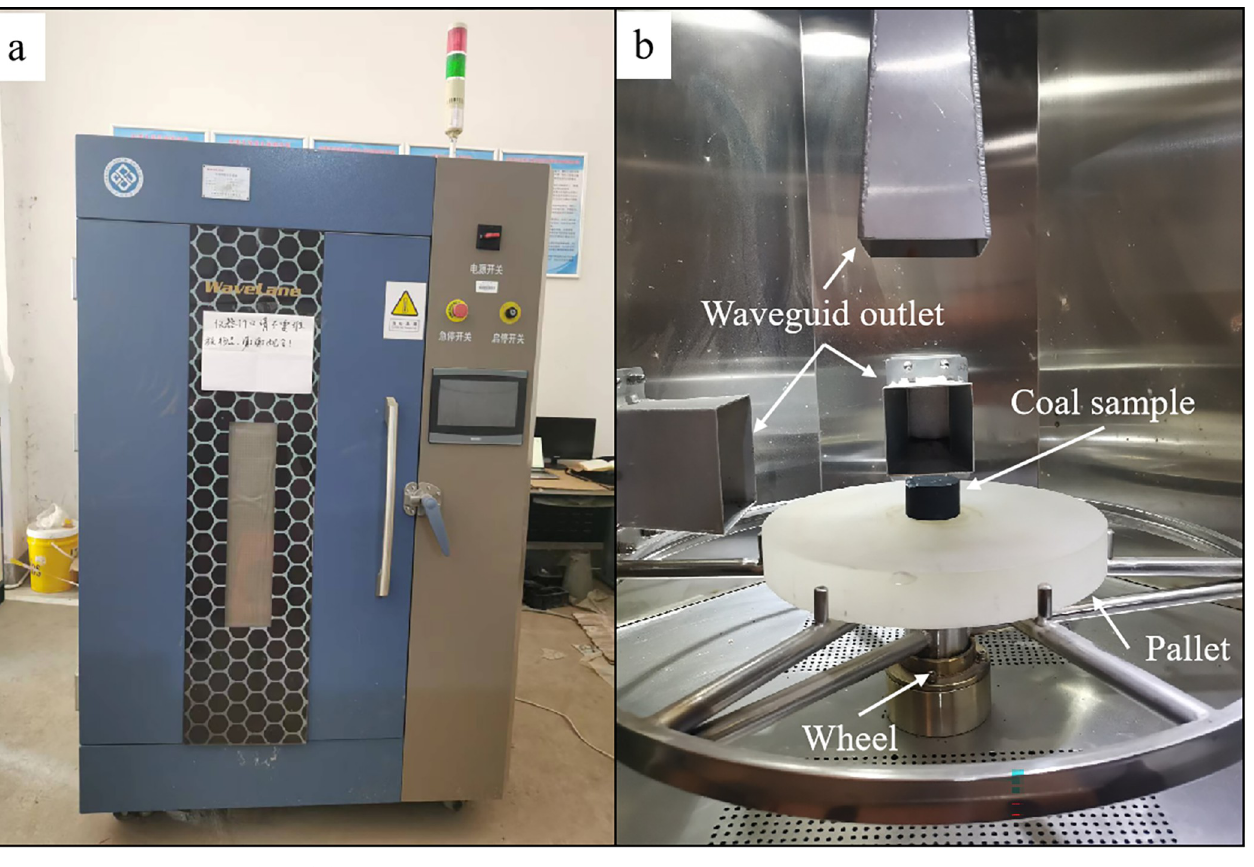
Fig 1. Microwave equipment and sample